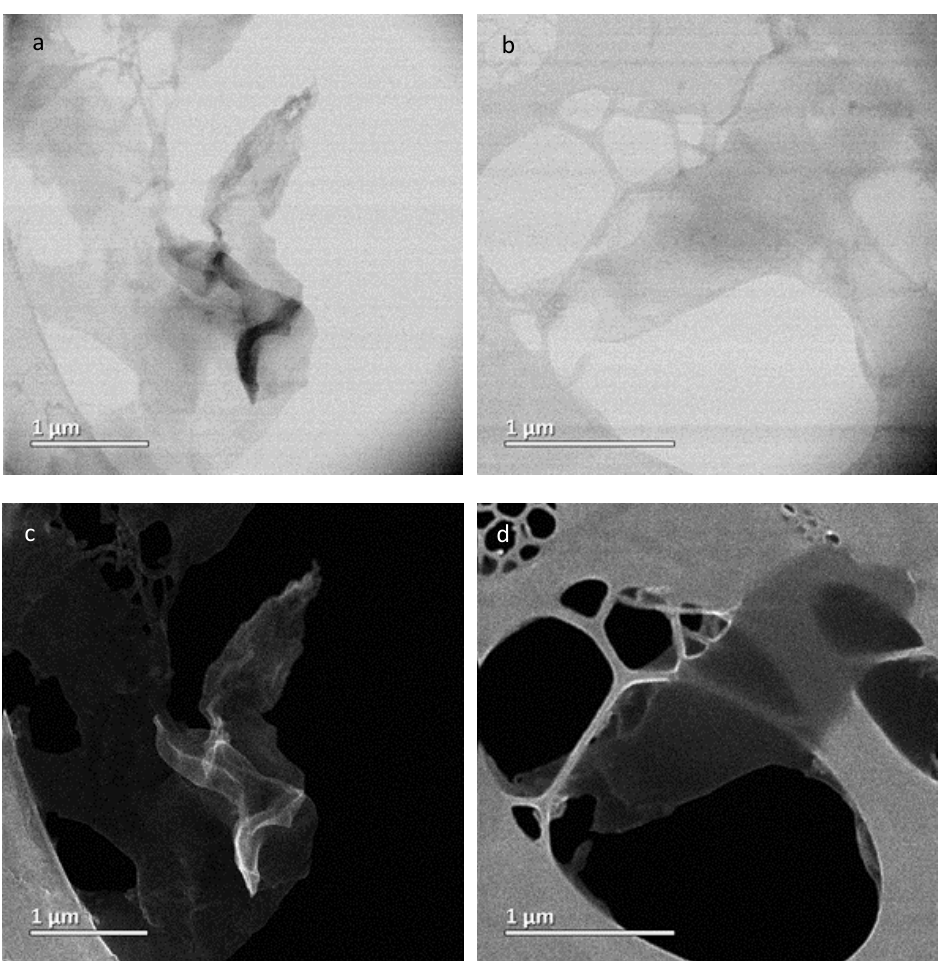
Figure 1. High-resolution transmission electron microscopy (HRTEM) ( a , b ) and field-emission scanning electron microscopy (FESEM) ( c , d ) images of GONRs with scale bar of 1 µ